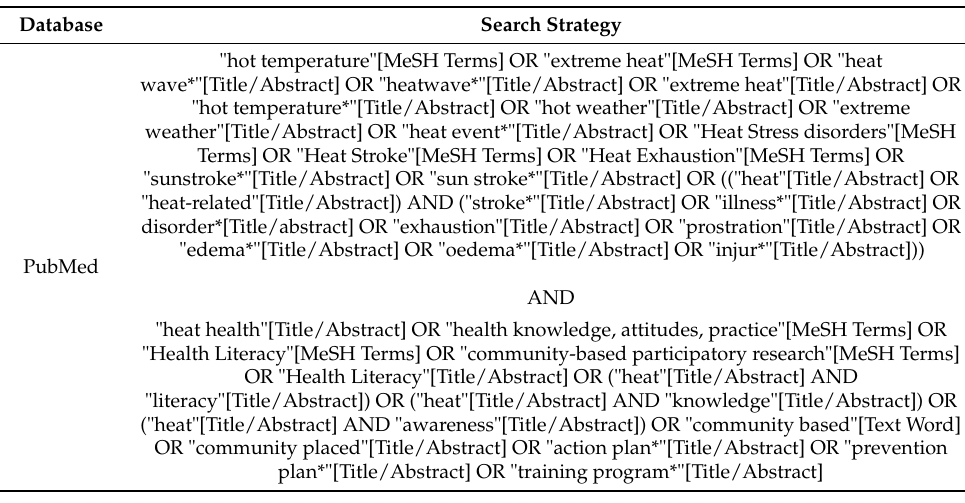
Table A1. Search strategy for the four data bases included in the literature